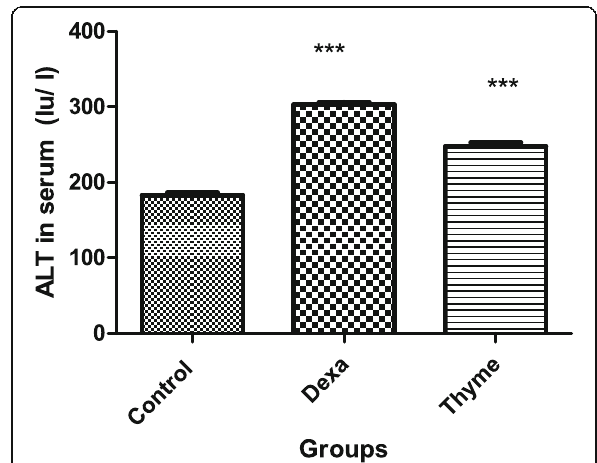
Fig. 3 The defensive role of thyme aqueous extract on serum alanine aminotransferase (ALT) activity in normal and dexamethasone (DXM)-treated rats. Percentage changes (%) were calculated by comparing normal group with DXM-treated group and pre-treated DXM groups with DXM-treated group